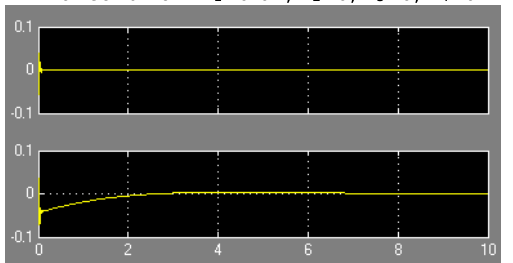
Fig 7 . The simulation result using optimal control.